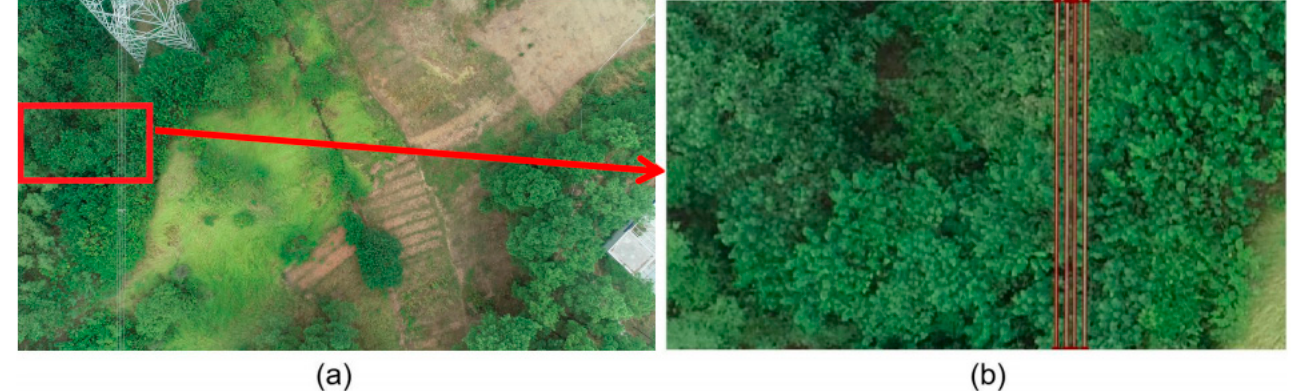
Figure 2. Data set making. ( a ) is an aerial drone image of the power lines; ( b ) is a partial image of ( a ) with labels added to the power lines in the image.